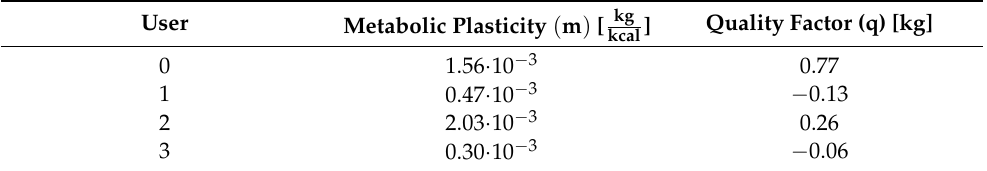
Table 3. Metabolic plasticity m and quality factor q for each user.